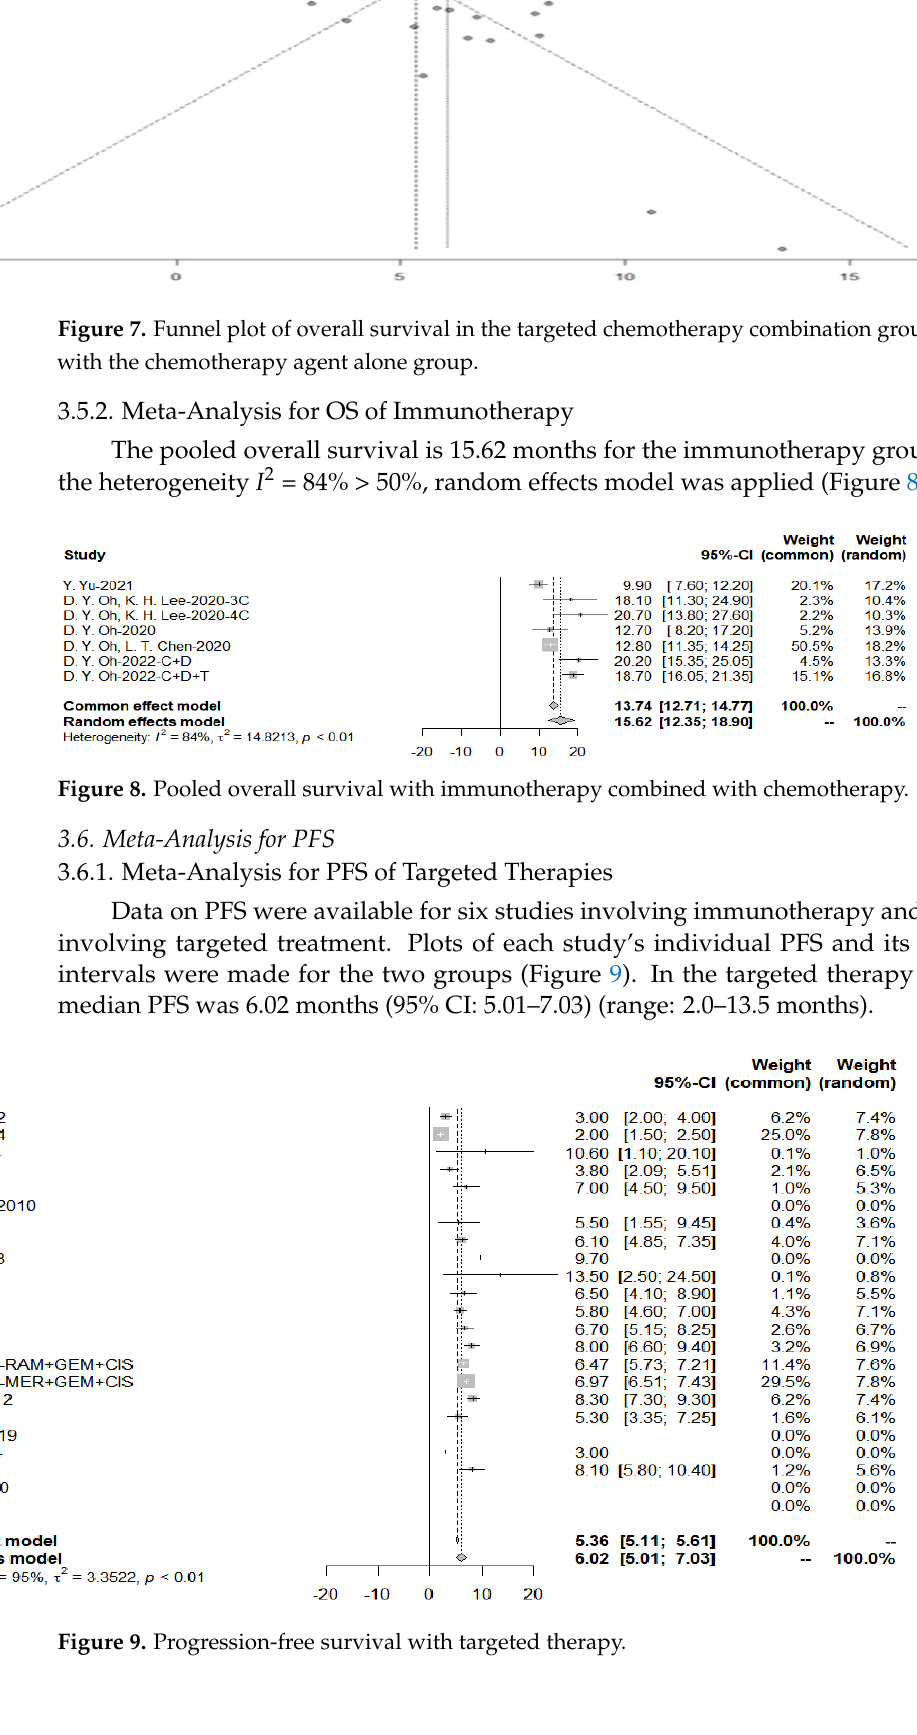
Figure 9. Progression ‐ free survival with targeted therapy.